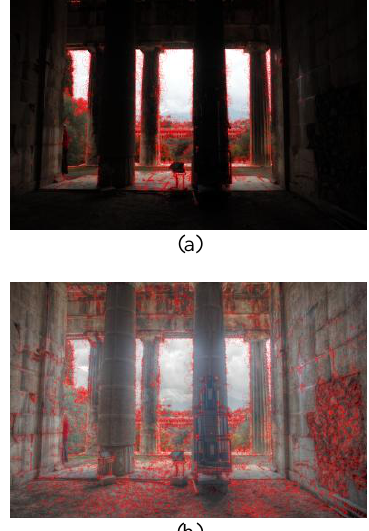
Figure 6: Features detected with SURF (a) on the SDR image (5047 points) and (b) on the HDR image (16843 points).